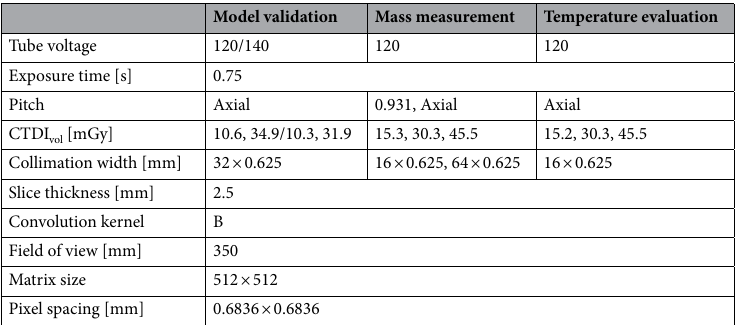
Table 2. Acquisition parameters for model validation, mass measurements, and temperature